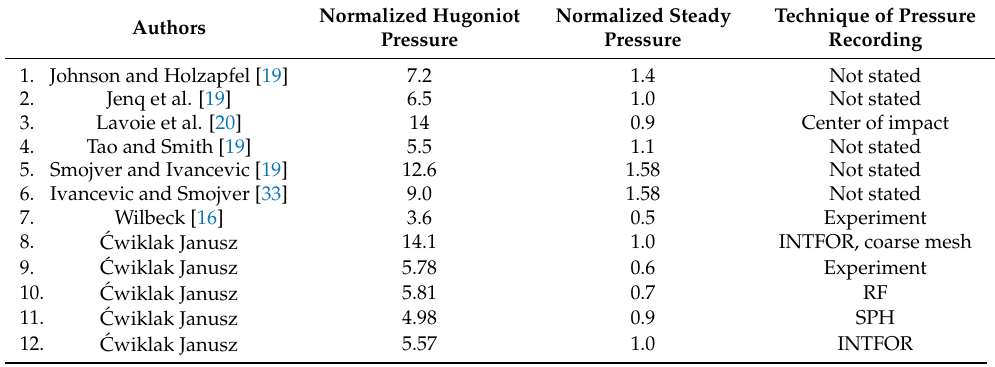
Table 4. Values of normalized Hugoniot’s and steady-flow pressure at a speed of 116